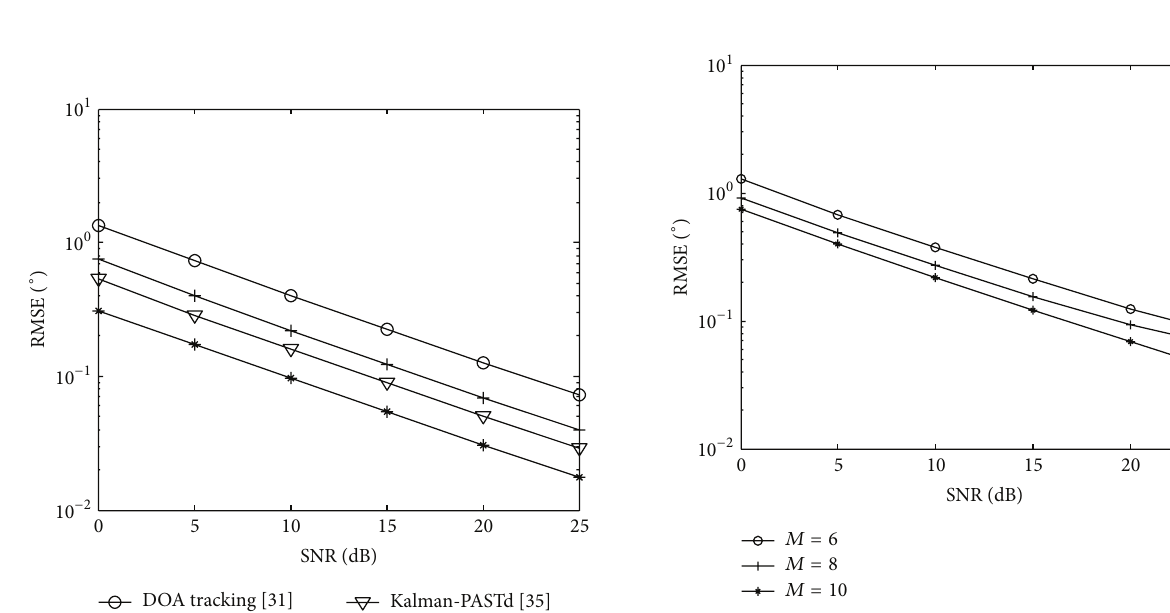
Figure 7: DOA tracking with different values of 𝐾 .